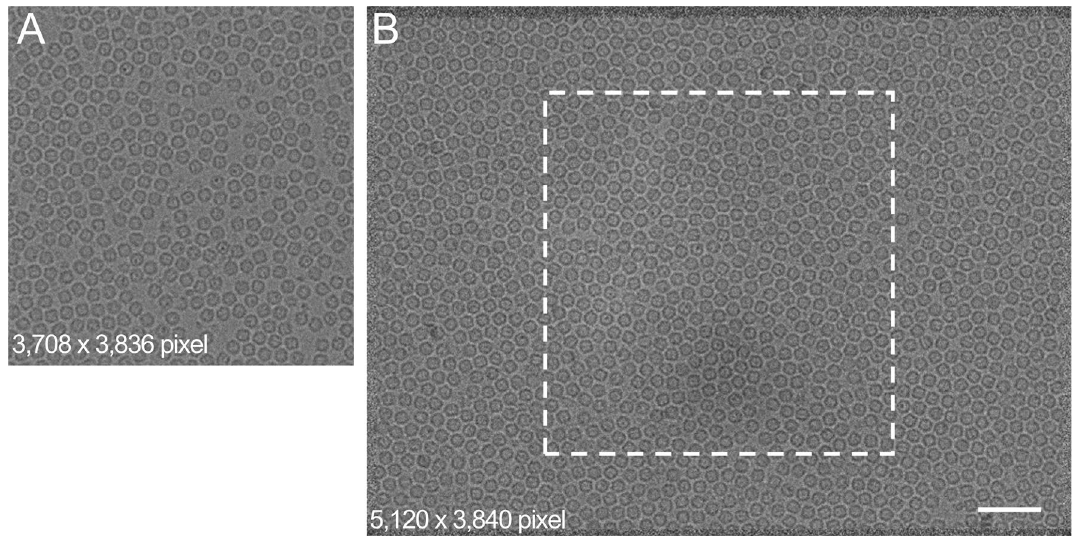
Figure 3. Comparison of micrographs from each microscope and detector combination. Representative micrographs from K2 Summit at 50,000 × ( A ) and from DE-20 at 50,000 × ( B ), each 2.4 µm under-focus. Micrographs scaled to equivalent size, scale bar 50 nm. White dashed box overlaid on image ( B ) highlights field of view difference between detectors. Micrograph dimensions are included in each figure. As a test sample, purified apoferritin was used. The number of particles included each micrograph were ( A ) 383, ( B ) 1,334, respectively. Absolute pixel dimensions are 5.0 × 5.0 µm 2 for K2 Summit DED and 6.4 × 6.4 µm 2 for DE-20